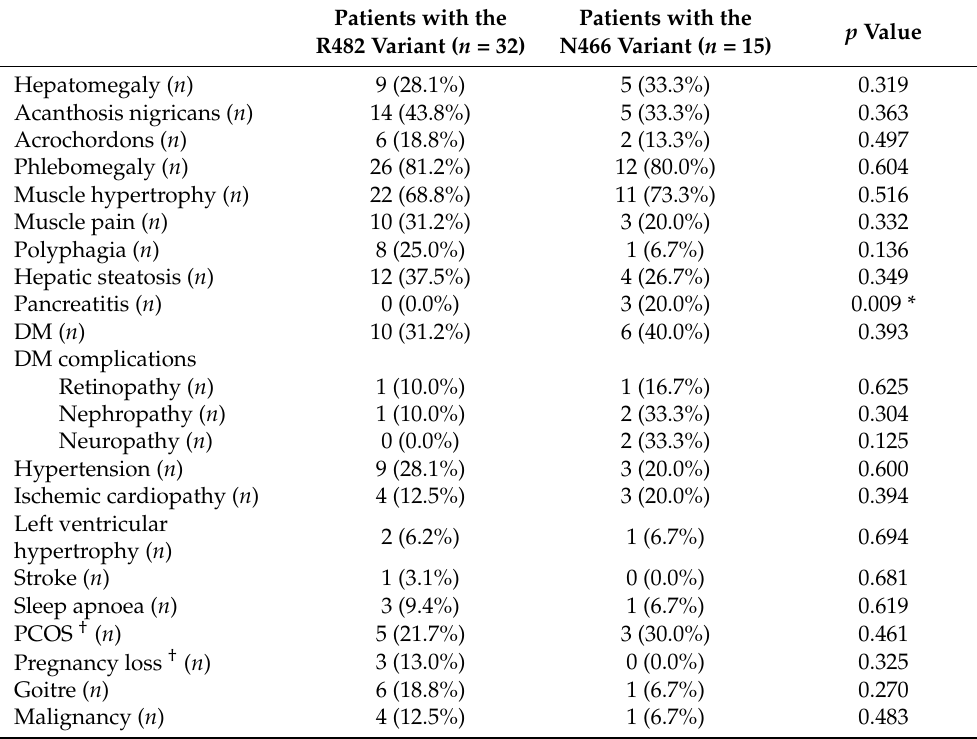
Table 3. Clinical data of FPLD2 patients depending on the variant in exon 8 of the LMNA gene. Patients with the Patients with the R482 Variant ( n = 32)